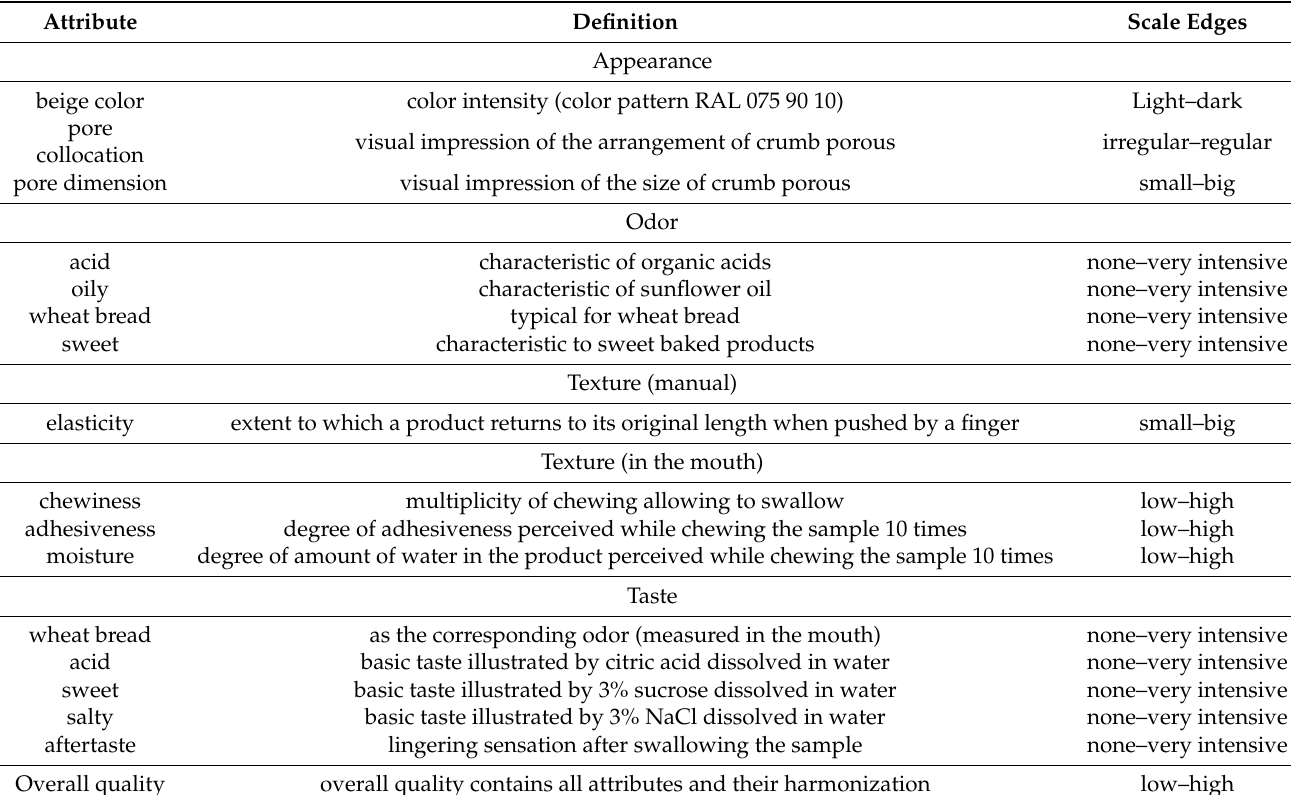
Table 6. Sensory attributes, their definitions, and scale edges used in the quantitative descriptive analysis